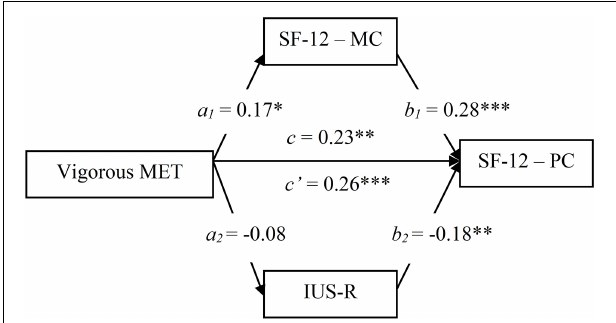
FIGURE 2 | Mediation model testing SF-12 Mental component and IUS-R as mediators of the relationship between Vigorous MET and SF-12 Physical component (M2). ∗ p < 0.05; ∗∗ p < 0.01; ∗∗∗ p < 0.001. BD, body dissatisfaction; DASS, Depression Anxiety Stress Scale; IUS, Intolerance of Uncertainty Scale; MET, Metabolic Equivalent Task; SF-12-PC, Short Form Health Survey–Physical